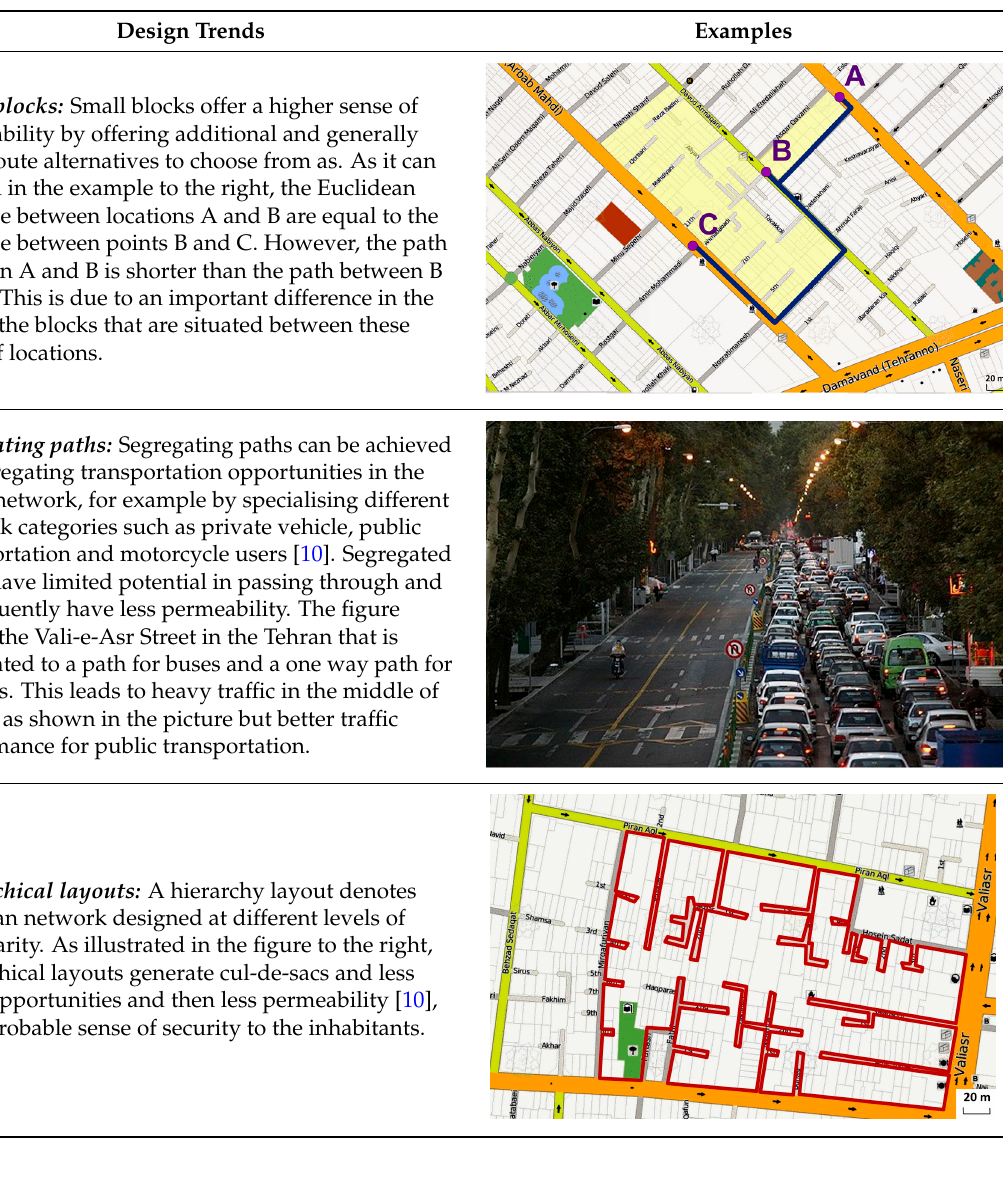
Table 2. Design trends that favour a permeable layout.